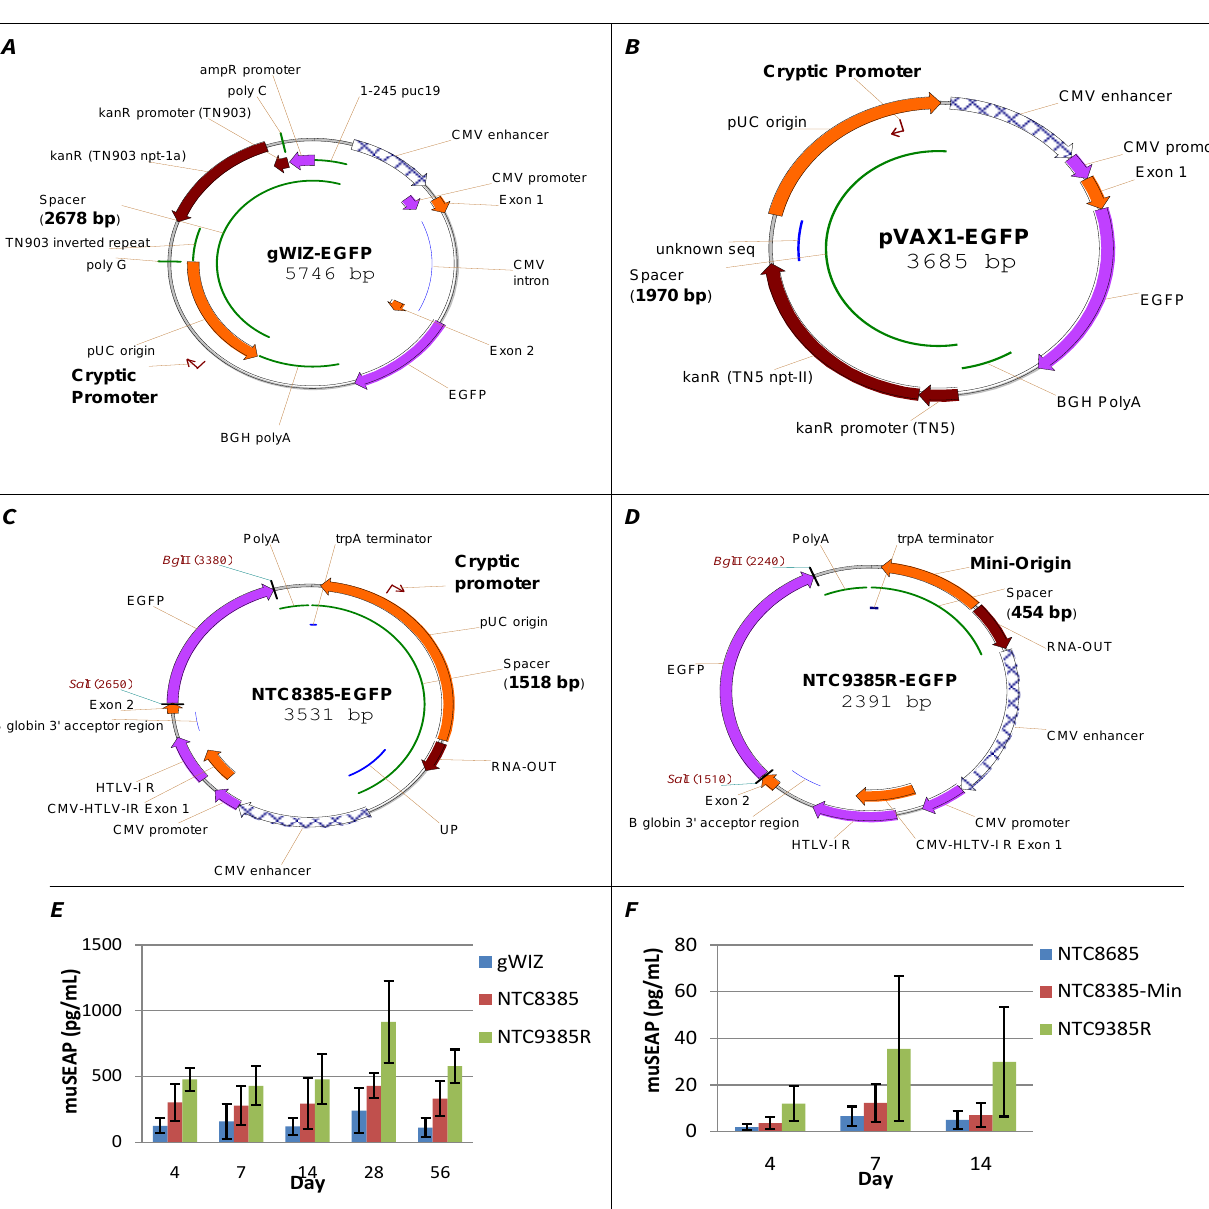
Figure 2. DNA vaccine vectors. ( a , b ) 1st; ( c ) 2nd; and ( d ) 3rd; generation DNA Vaccine vectors; ( e ) 2nd and 3rd generation vectors increase in vivo expression compared to first generation vector gWIZ. 5 µg muSEAP vectors delivered intramuscularly with EP to mice on day 0, serum muSEAP assayed on indicated days. 3rd generation vector NTC9385R has significantly higher expression than gWIZ or 2nd generation vector NTC8385 ( p -value = 0.05; Mann-Whitney rank-sum test); ( f ) 3rd generation vectors dramatically increase in vivo expression, compared to 2nd generation. 50 µg muSEAP vectors in 50 µL saline delivered intradermally to mice with EP on day 0, muSEAP assayed on indicated days. 3rd generation vector NTC9385R has significantly higher expression than 2nd generation vector NTC8685 ( p -value = 0.05; Mann-Whitney rank-sum test). NTC8685 is a 2nd generation vector similar to NTC8385. The NTC8385 1,518 basepair (bp) bacterial region (spacer region) is reduced to 855 bp in NTC8385-min and 454 bp in NTC9385R. This compares to 2,678 bp for gWIZ, and 1,970 bp for